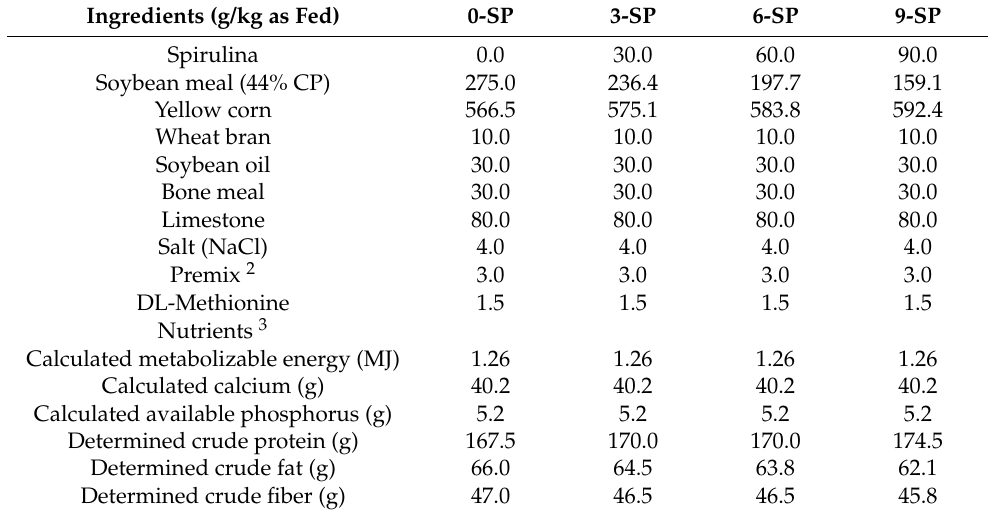
Table 2. Composition of the experimental diets 1